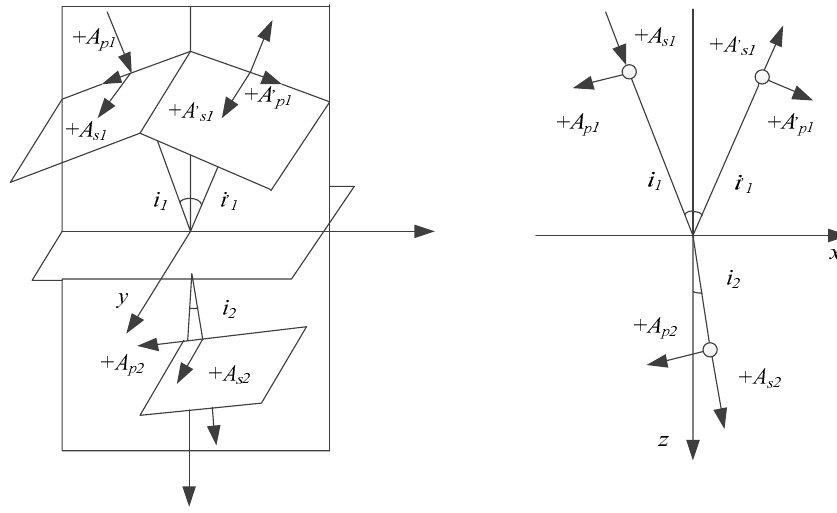
Figure 5. Reflection and its schematic diagram.